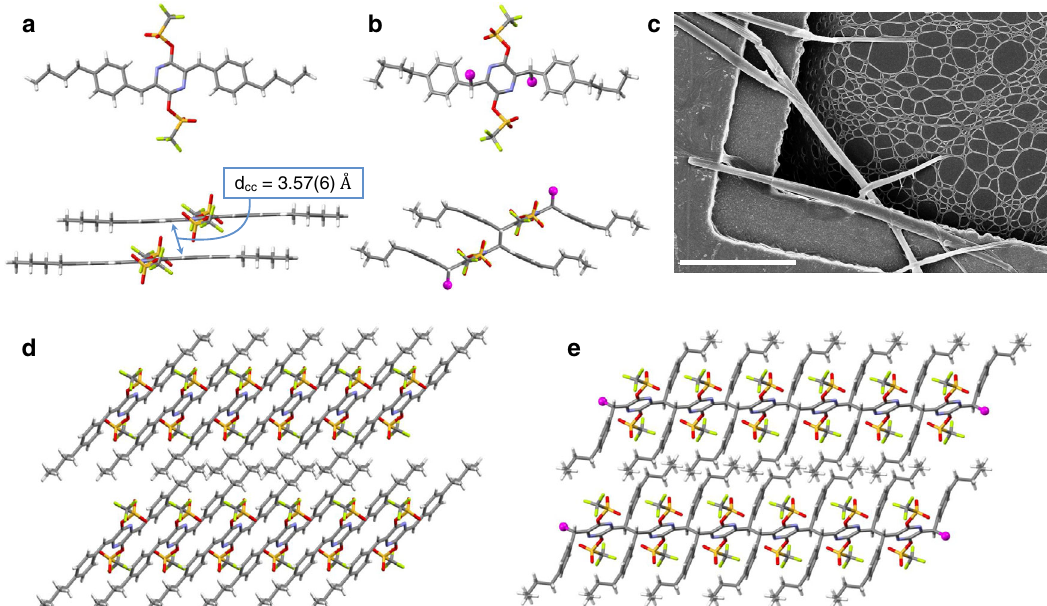
Fig. 2 Solid-state structures of monomer 2 and polymer P2. a X-ray crystal structure of 2 showing molecular structure, and d CC — the distance between reactive sites of two neighboring molecules. b CryoEM structure of polymer P2 showing the unit cell structure (top), and a dimeric unit (bottom). c Scanning electron microscopy image of crystals of P2 on a TEM grid similar to those used to obtain its structure by cryoEM. Scale bar: 10 μ m. d and e Analogous views of the columnar stacks of monomer 2 and the polymeric chains of P2 . Atom color scheme: carbon = gray, nitrogen = blue, oxygen = red, sulfur = yellow, fl uorine = green, hydrogen = white, magenta balls represent the truncated polymer chain in polymer P2